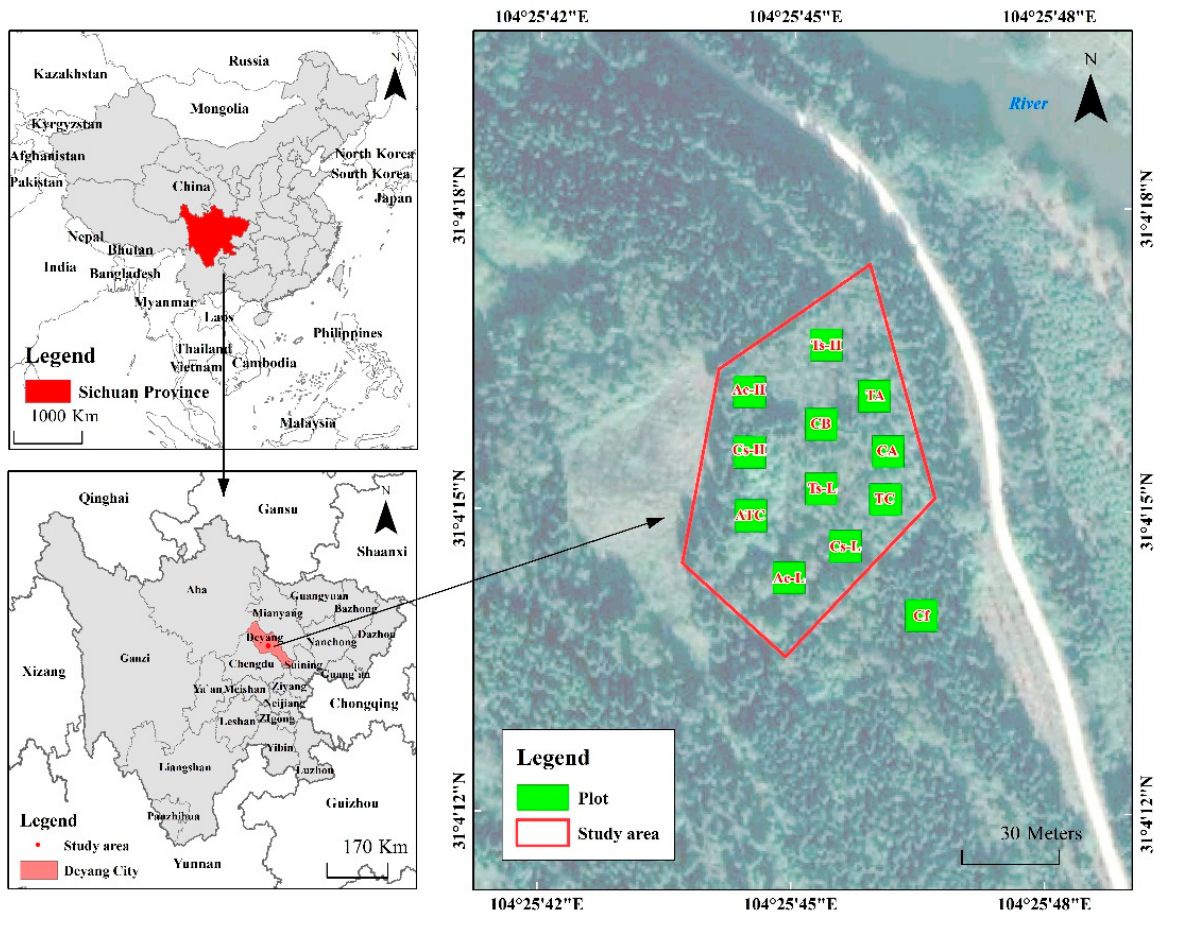
Figure 1. Geographical location of the study area .